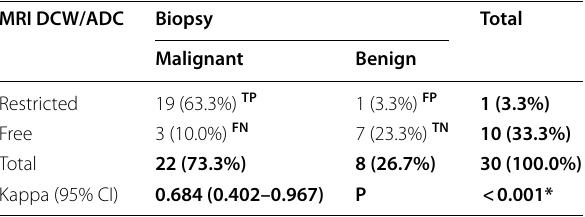
Table 6 Agreement between biopsy (reference) and MRI DWI/ ADC findings